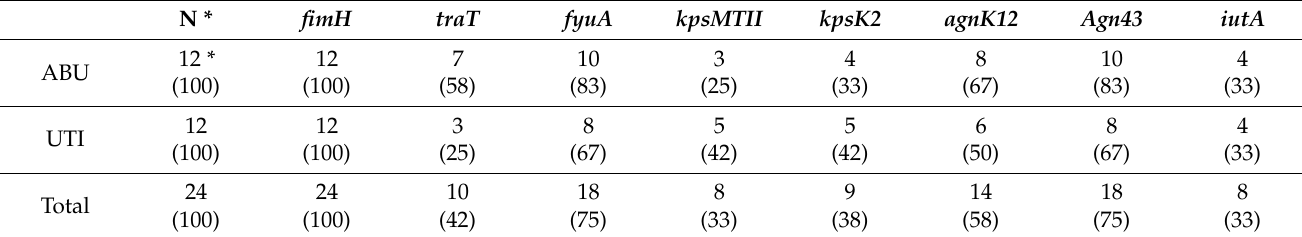
Table 2. Distribution of the most common virulence genes identified in E. coli from urine in patients with asymptomatic bacteriuria (ABU) and urinary tract infection (UTI). For explanation of virulence genes, see text.